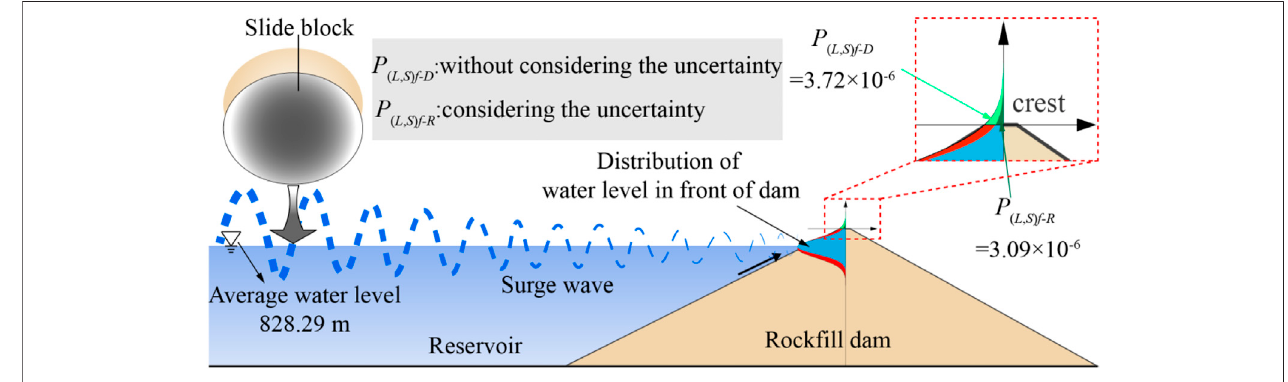
FIGURE 8 | Comparison of results obtained by two